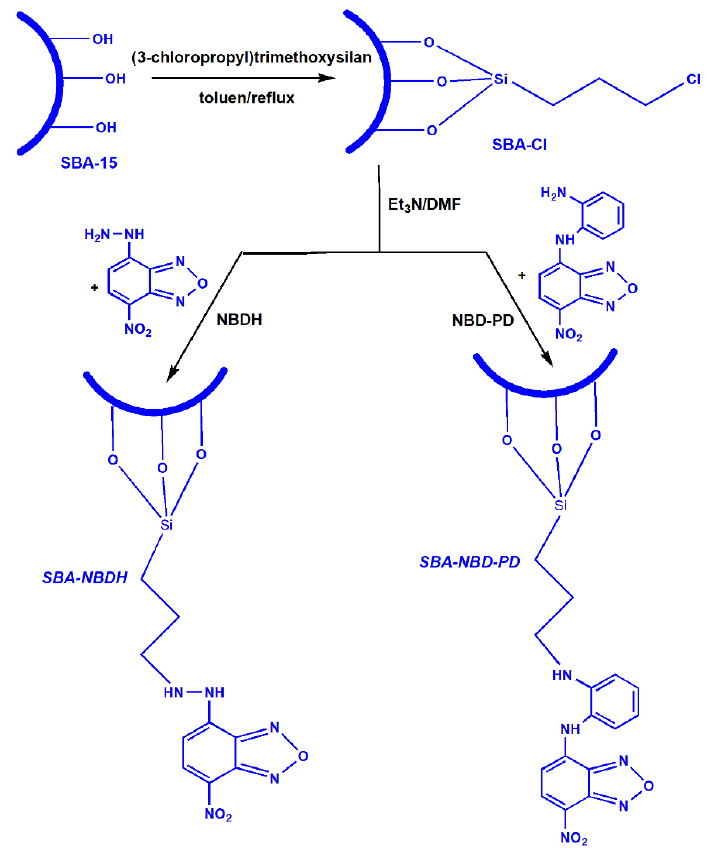
Scheme 1. Schematic protocol for functionalization of SBA-15 with NBD